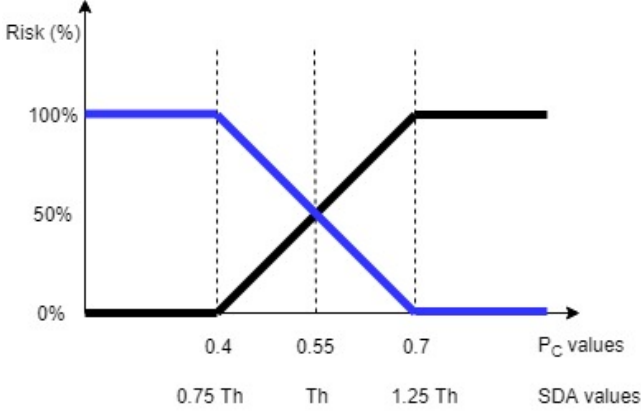
Figure 2. The black line represents fuzzy sets (Fc) for weighing amplitude changes of peaks (ACP), and the blue line represents Fc for standard deviation of airflow (SDA) values for risk evaluation.